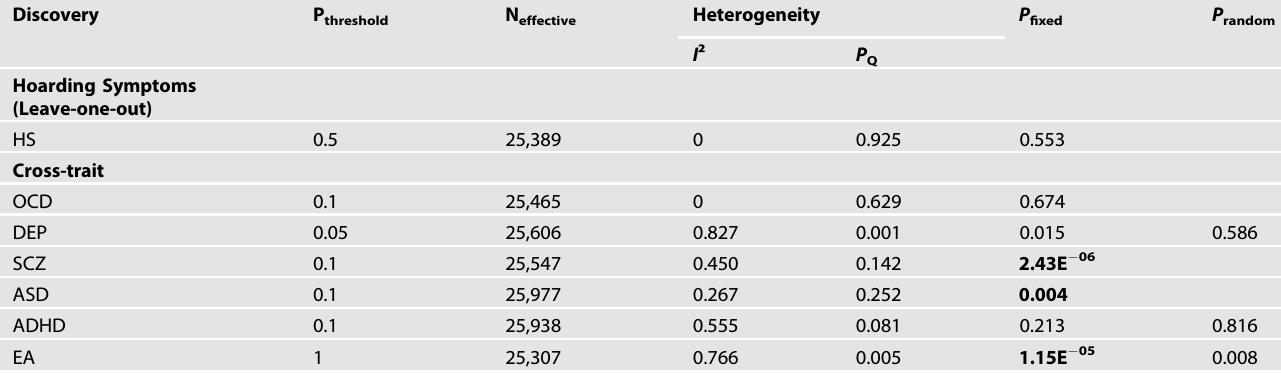
As measures of heterogeneity of PRS associations across all target datasets, Higgin ’ s I ² statistic and the p -value for Cochran ’ s Q test ( P Q ) are reported. P fi xed and P random list the p -values of a fi xed and a random-effects model, respectively. A random effects model was only calculated if there was substantial ( I ²>0.5 and/ or P Q <0.05) heterogeneity across the datasets. The effective sample size ( N effective ) is summed over the effective sample size of every target dataset. For STR, NTR, and TwinsUK the effective N was determined based on the actual N (including family members) weighted by the ratio of the squared SE from the GEE sandwich-corrected model and the naive model (no correction), for SfS the total sample N was used. Bonferroni-corrected signi fi cant p -values (<0.05/ 7 = 0.00714) are in analyses between LOO GWAS analyses of age-separated STR sub- Supplementary Fig. S11 for a QQ-plot). Also, none of 15,483 tested cohorts (Supplementary Table S5), age-separated NTR sub-cohorts gene-sets reached the Bonferroni-corrected signi fi cance (Supplementary Table S6) and the respective left-out cohort. The threshold. STR cohorts were divided into four age groups, pertaining to their division into separate phenotyping rounds (CATSS15 mean age = 15.46; CATSS18 mean age = 18.56; CATSS24 mean age = 23.84; YATSS mean age = 23.93), while the NTR data was separated into three age groups (group1 < 30 years; group2 30 – 45 years; group3 > 45 years). The sign test results at the p -